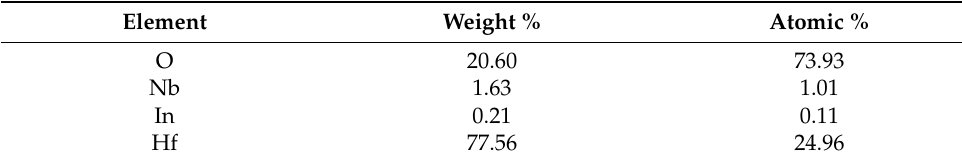
Table 1. Local elemental compositions of the HINO-0.005 deduced from EDS. Figure 6. ( a ) P-E loop and I-V curves of HINO-0.005; ( b ) XRD patterns (main panel), SEM image (right inset), and picture of the sensor (left inset) of HINO-0.005; ( c ) EDS spectrum for HINO-0.005.